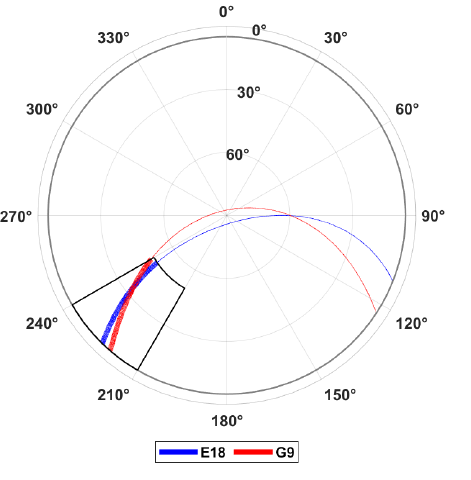
Figure 9. Skyplot for satellites E18 and